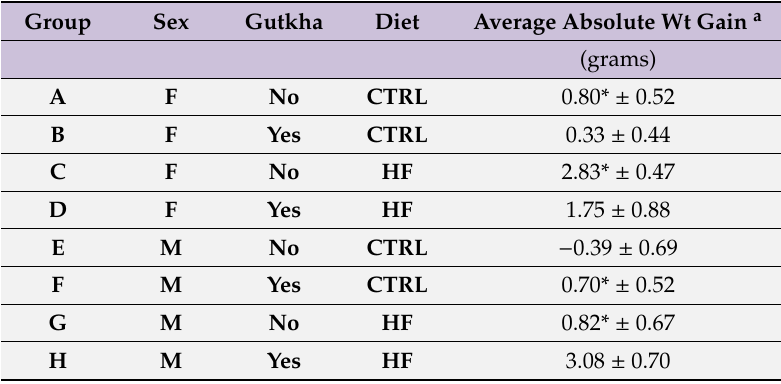
Table 1. Prenatal gutkha exposure followed by a high fat diet (HFD) significantly increased weight gain in male offspring.